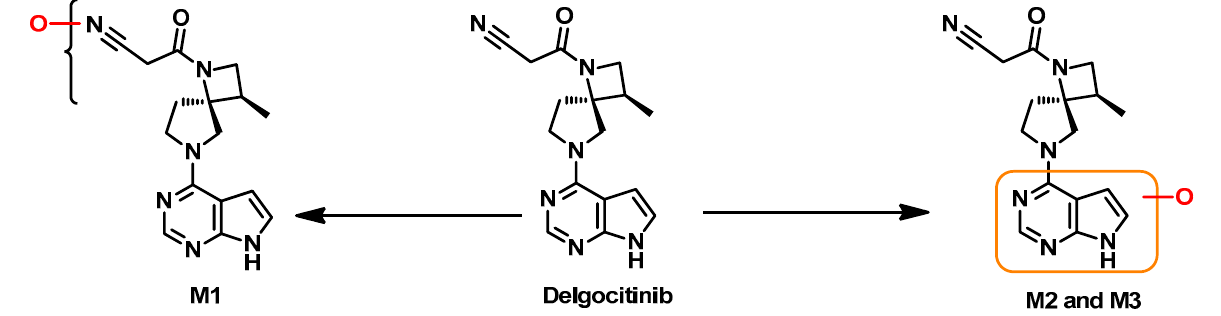
Figure 25. Proposed metabolic pathways and major metabolites of delgocitinib based on the data of the deliberation results [103].